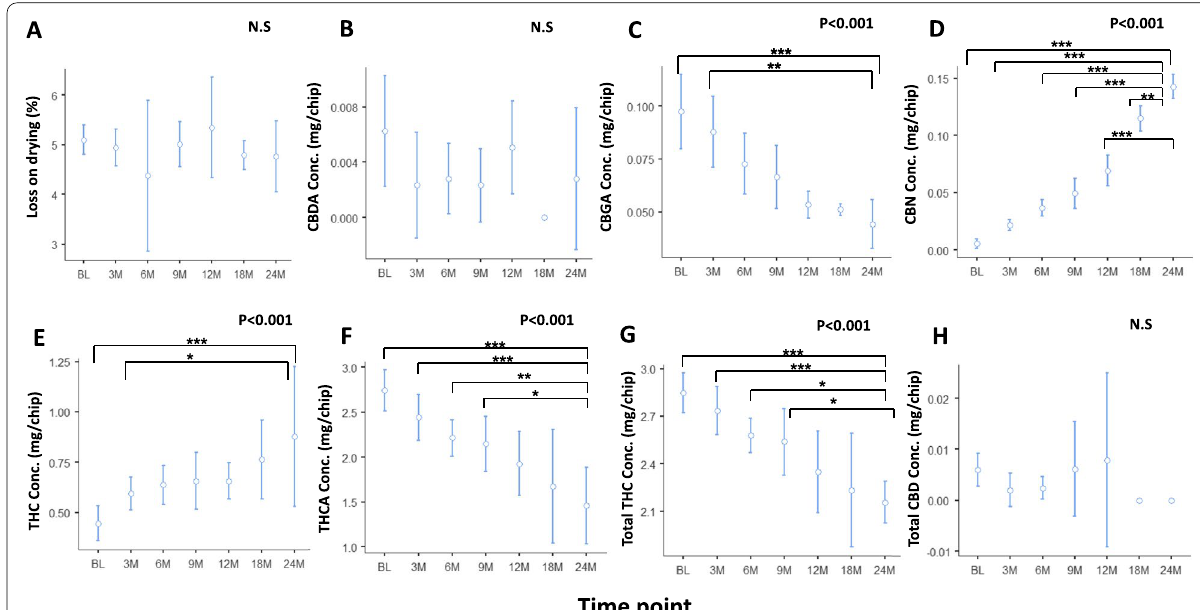
Fig. 3 Amount of major phytocannabinoids in MC stored in Syqe cartridges at room temperature over 2 years. The middle circle represents mean value and the upper and lower lines represent the upper and lower 95% confidence interval values. BL, baseline; M, month; CBDA, cannabidiol acid; THC, (-)-∆ 9 -trans- tetrahydrocannabinol; THCA, (-)-∆ 9 -trans- tetrahydrocannabinol acid; CBGA, cannabigerolic acid; CBN, cannabinol; “Total” represents the sum of the acid and the neutral components. Statistically significant differences between times of storage were calculated by one-way ANOVA, utilizing Fisher’s exact test analyses (whenever significant, stated as the p value and when not significant stated as N.S.), followed by a Tukey post hoc multiple comparison test (*, p <0.05; **, p <0.01; ***, p